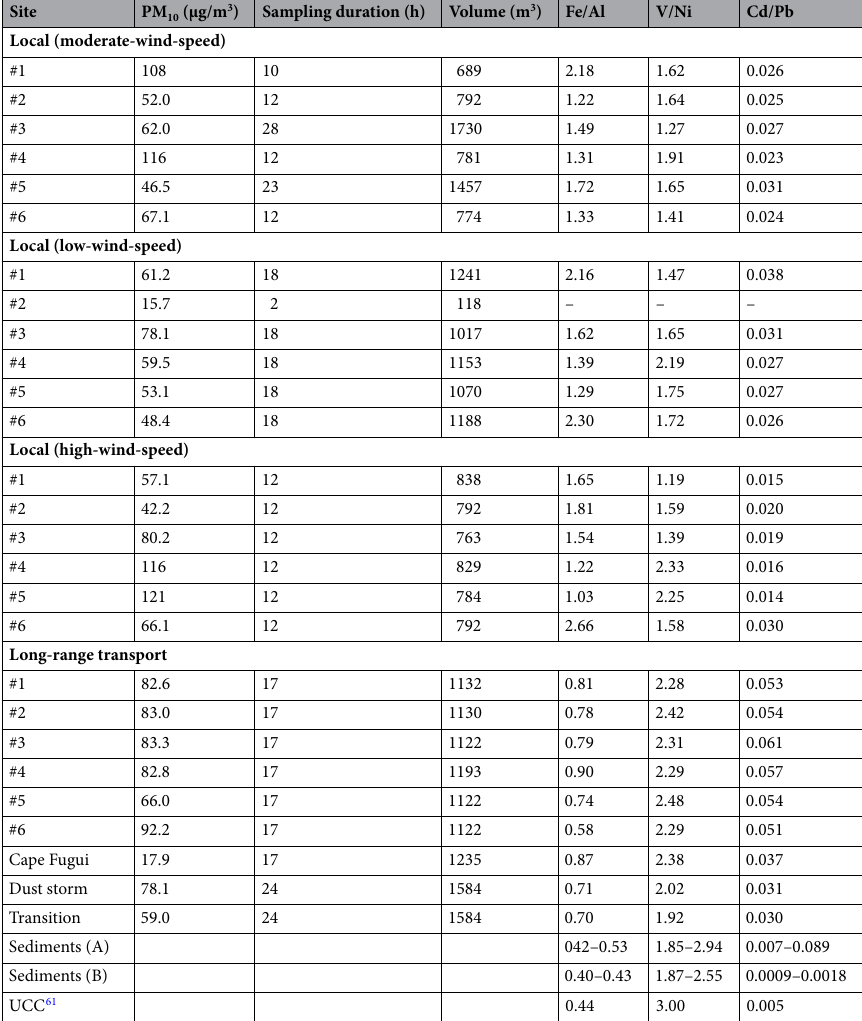
Table 2. PM 10 mass, sampling duration, filtered air volume, and selected elemental ratios for PM 10 samples collected in this